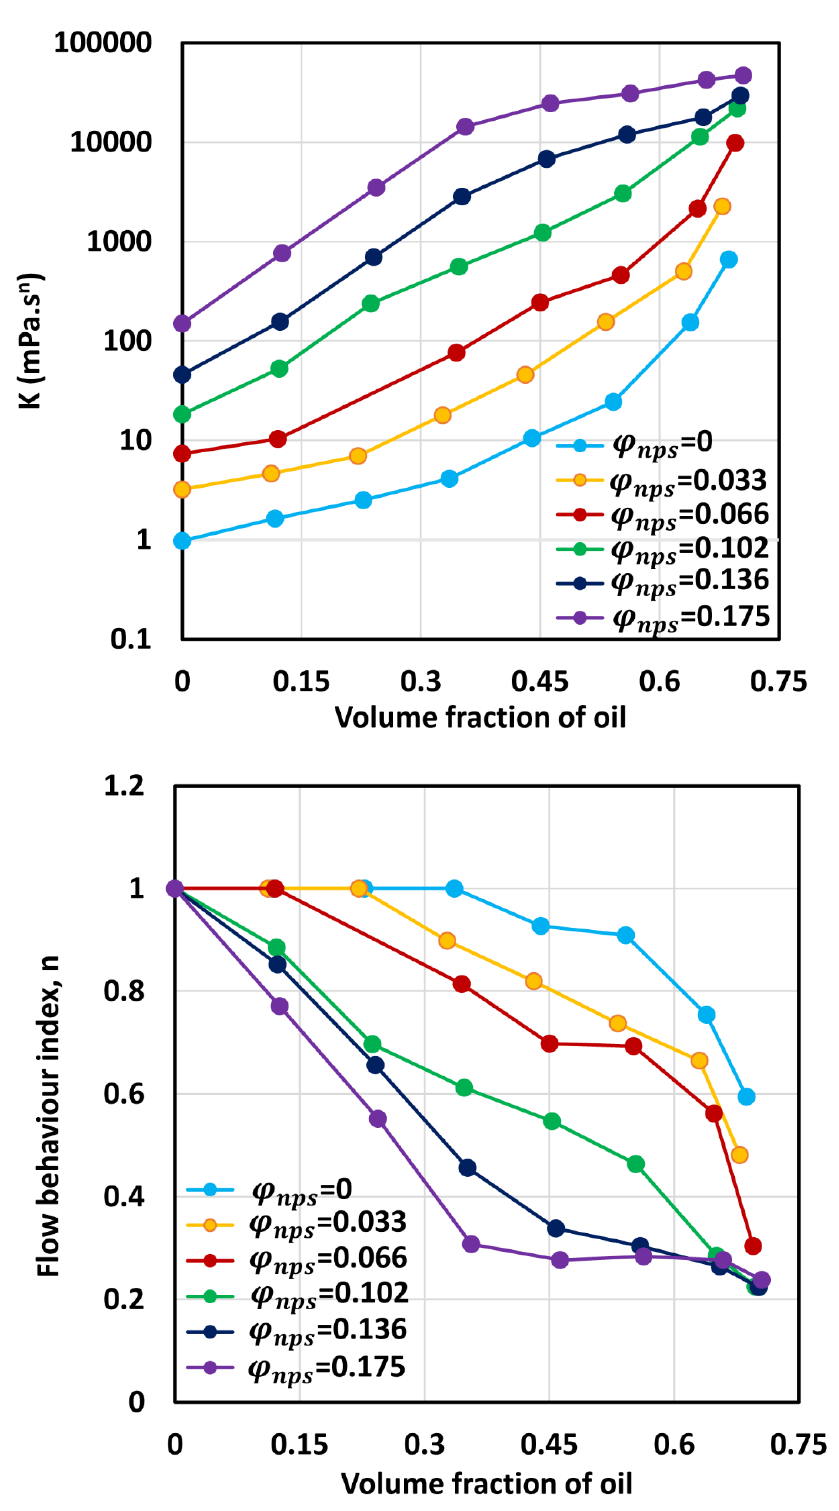
Figure 11. Consistency index ( K ) and flow behavior index ( n ) of O/W emulsions thickened with starch nanoparticles .